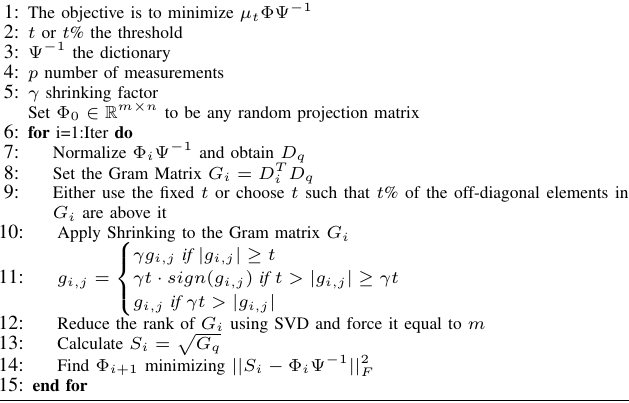
Algorithm 1 Elad’s Projection Matrix Optimization Algo- rithm.